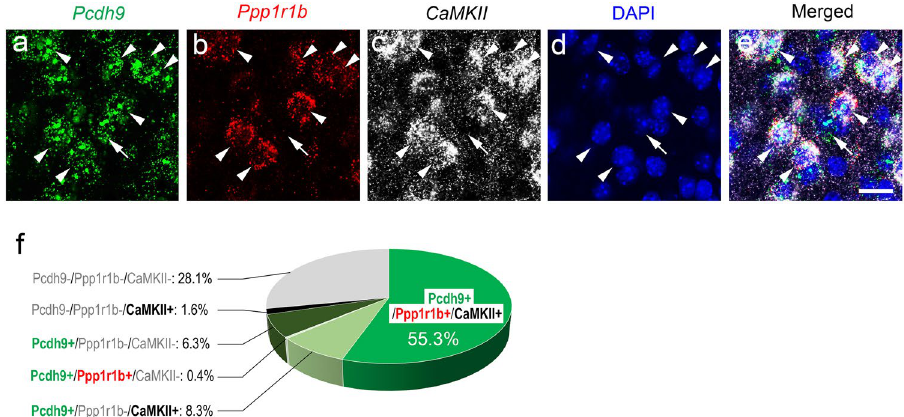
Figure 2. Identification of Pcdh9 -expressing neurons. ( a – e ) Expression of Pcdh9 mRNA; Pcdh9 ( a ) was compared with Ppp1r1b ( b ) and CamKII ( c ) using multi-color in situ hybridization. Arrowheads indicate Pcdh9 + neurons that also expressed Ppp1r1b mRNA, whereas arrows indicate Pcdh9 + neurons that did not express